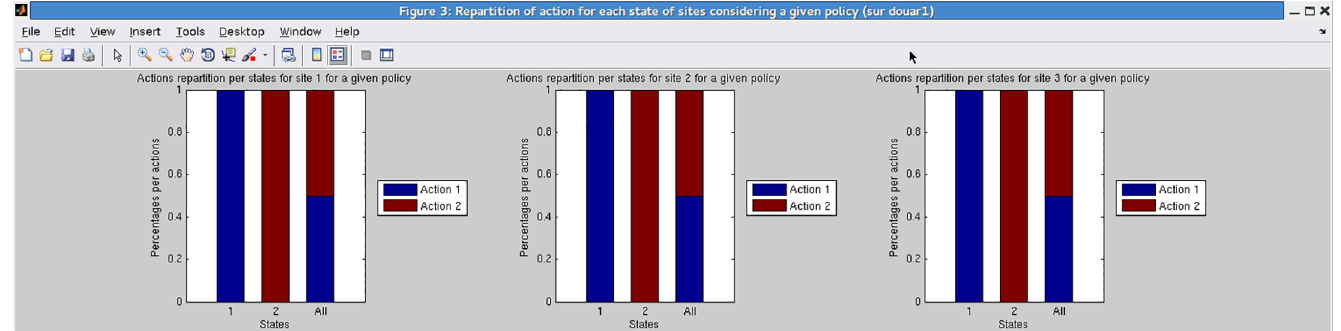
Fig 2. Toy epidemiological management problem: proportions of neighborhood configurations for which the GMDP policy prescribes action 1 and action 2, at each of the three sites.